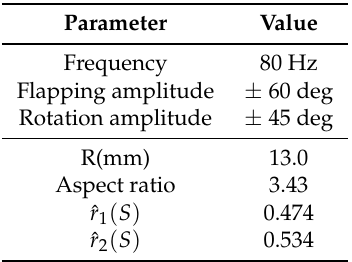
Table 1. Zou et al. Wing